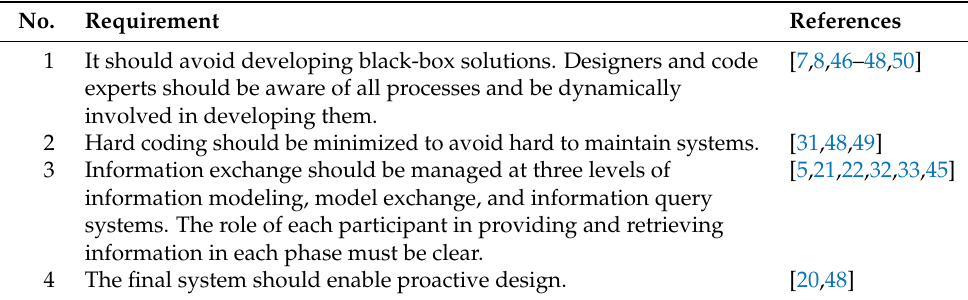
Table 1. Key requirements for developing an ARC